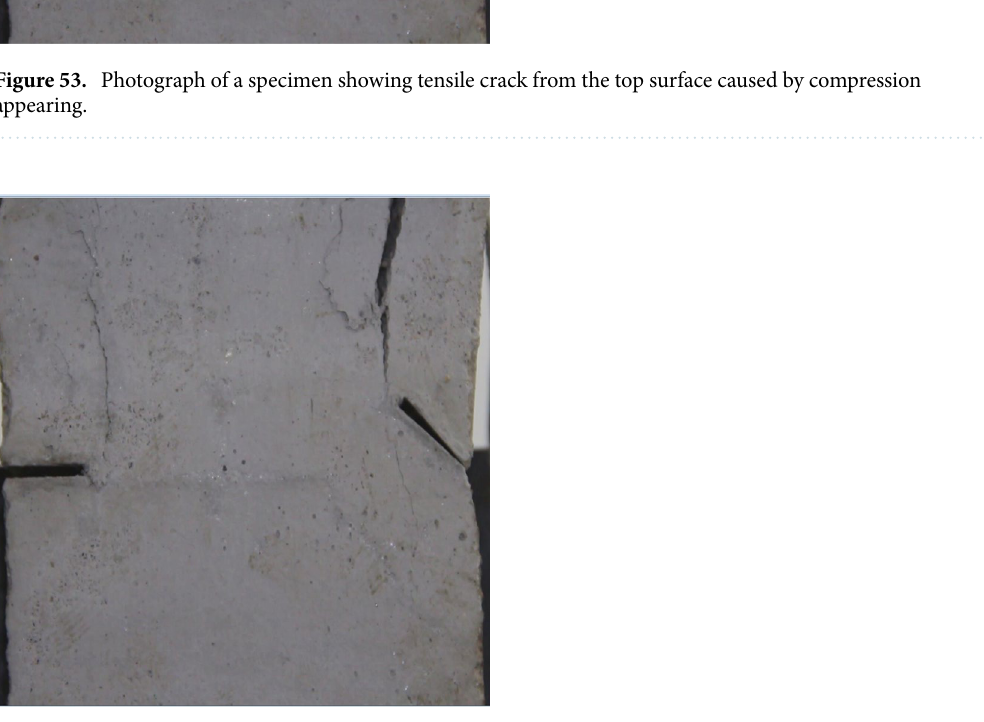
Figure 54. Photograph of a specimen showing tensile crack from the top surface caused by compression